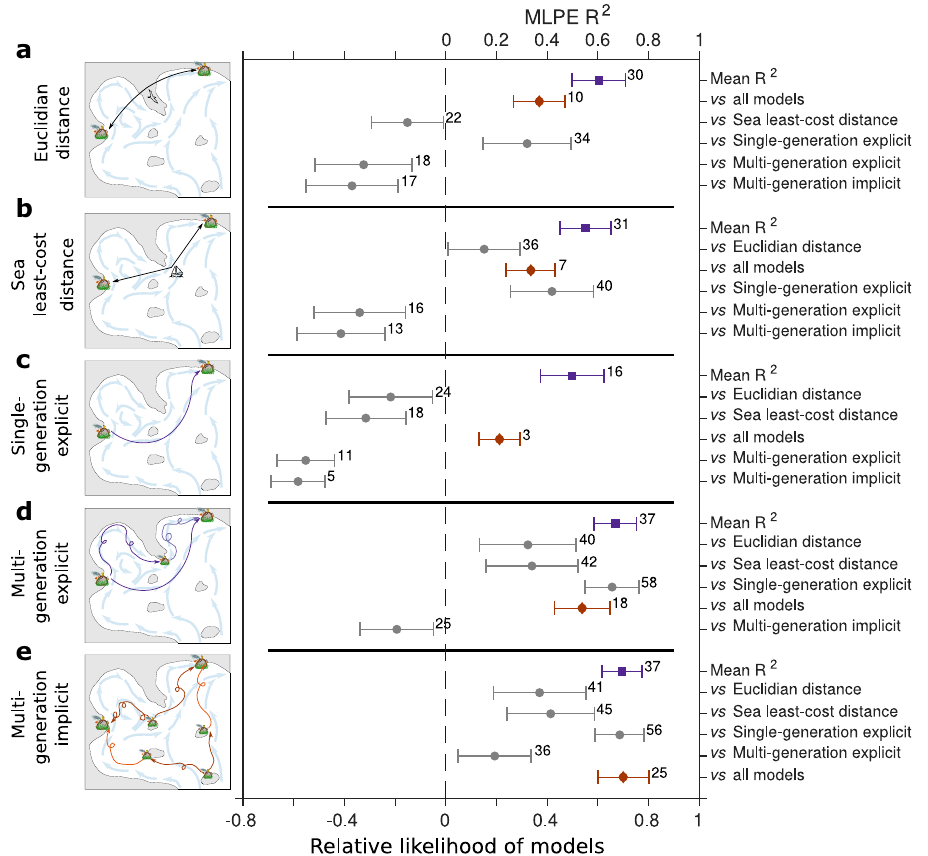
Fig. 3 | Cross-comparison of gene fl ow predictive models. Purple squares indi- cate mean MLPE linear mixed model R 2 , red diamonds indicate the relative like- lihoodofthe reference model (depictedon the left) vs the four remaining models, and grey dots indicate the relative likelihood difference of the reference model (depicted on the left) vs each of the four remaining models. Comparative analyses are made for a IBD (Euclidian) model, b IBD (sea-least-cost) model, c single- generation explicit dispersal model, d multi-generation explicit dispersal model and e multi-generation implicit dispersal model. Only the signi fi cant predictions ( p value*) of each reference model (left) are considered to compute the mean R 2 , while all the 58studies are used to compute the relative likelihood and the relative